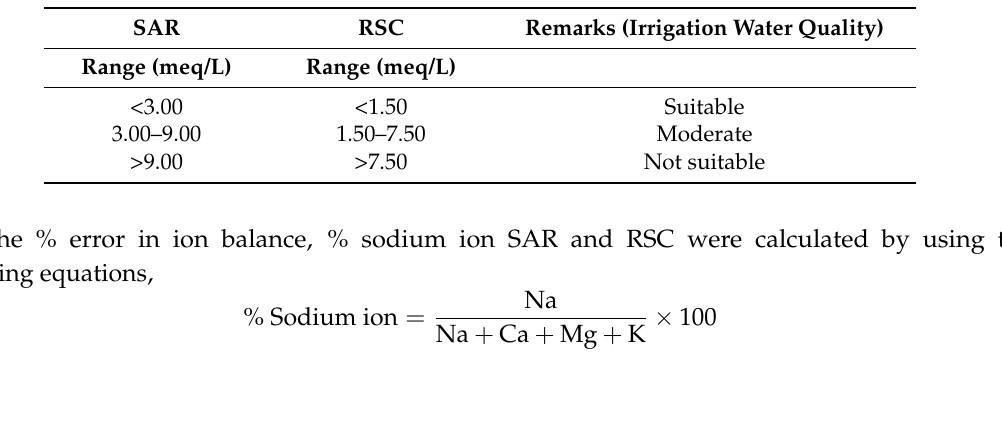
Table 1. Sodium adsorption ratio (SAR) and residual sodium carbonate (RSC) values for irrigation water quality standards